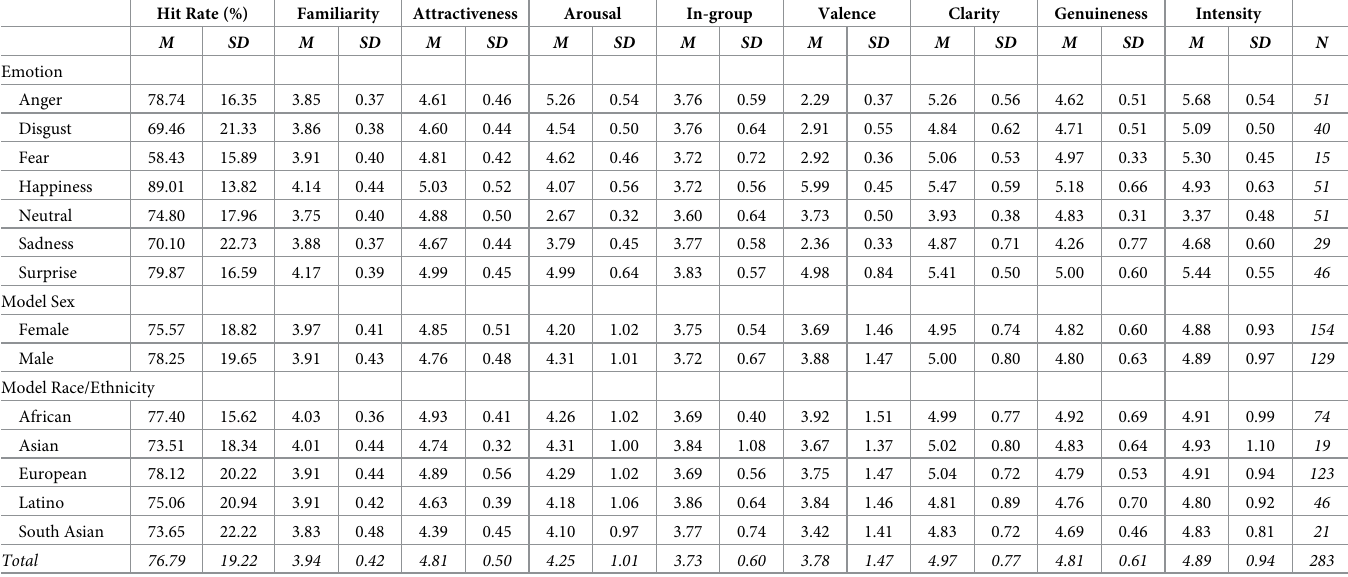
Table 6. Hit rates (%) and subjective ratings according to emotion, sex of the model and model’s race/ethnicity. Hit Rate